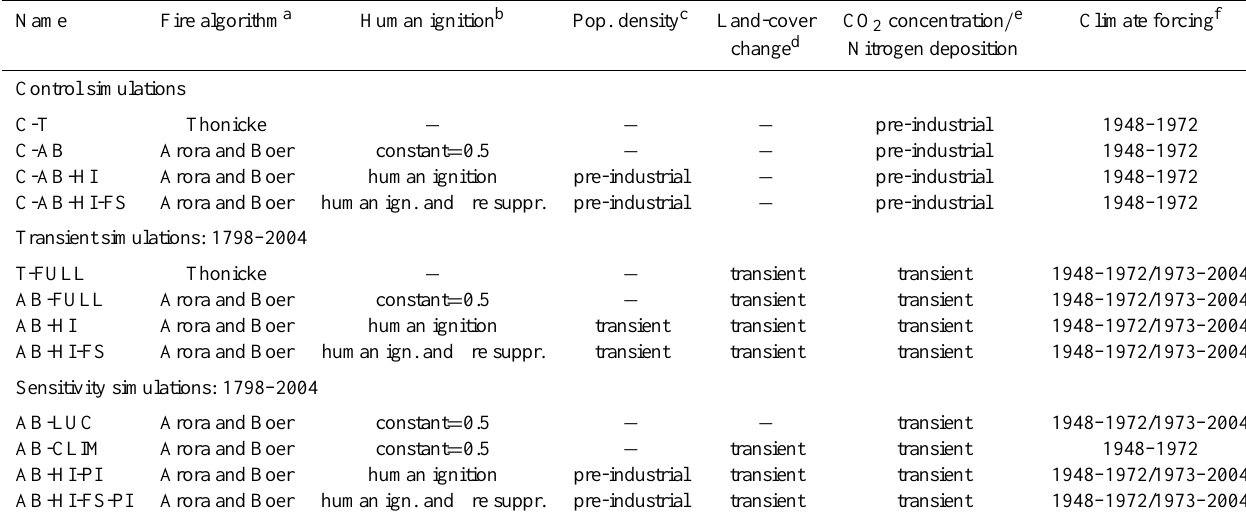
Table 1. Control and transient model simulations analyzed in the present study. Simulations used different fire algorithms, different treatment of human ignition potential, and different assumptions about land-cover change and wood harvest as well as climate